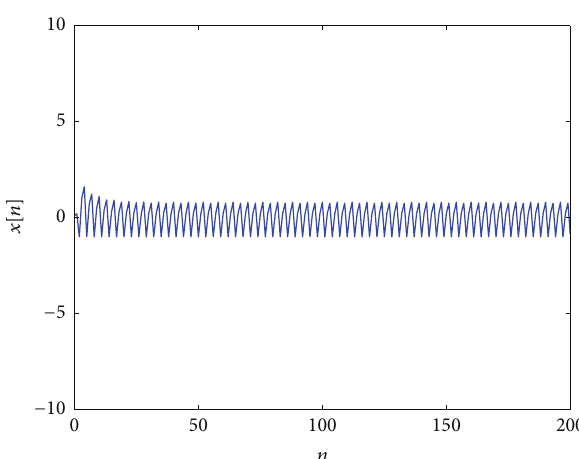
Figure 3: Eventually steady periodic cycle satisfies condition (i).